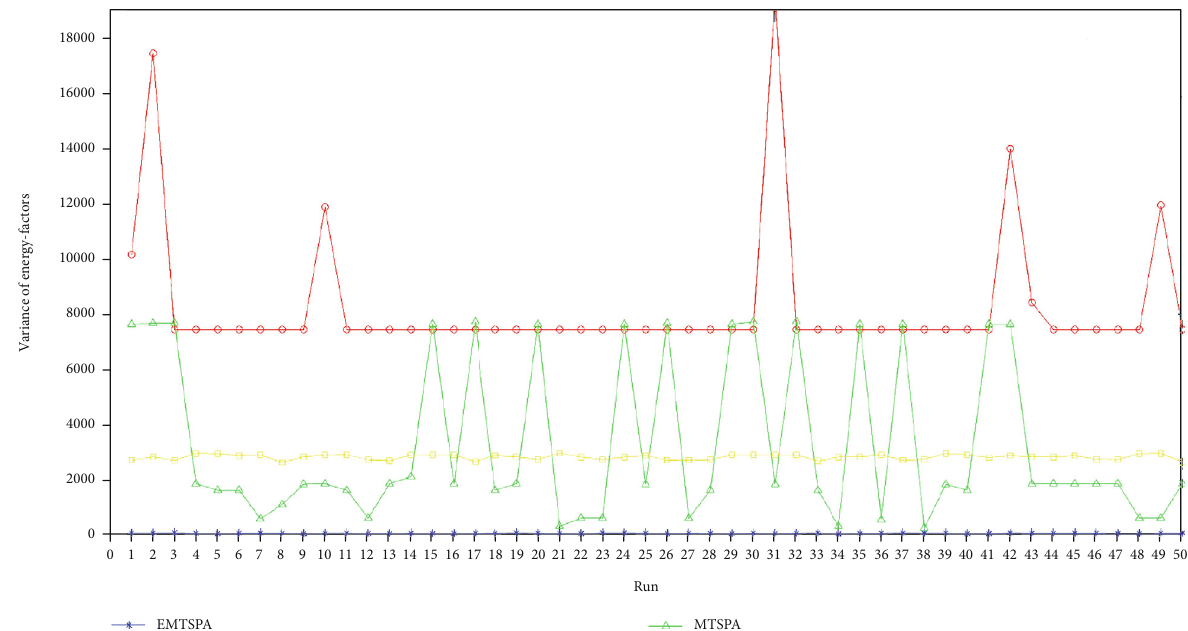
Figure 10: VEF in 50 rounds of